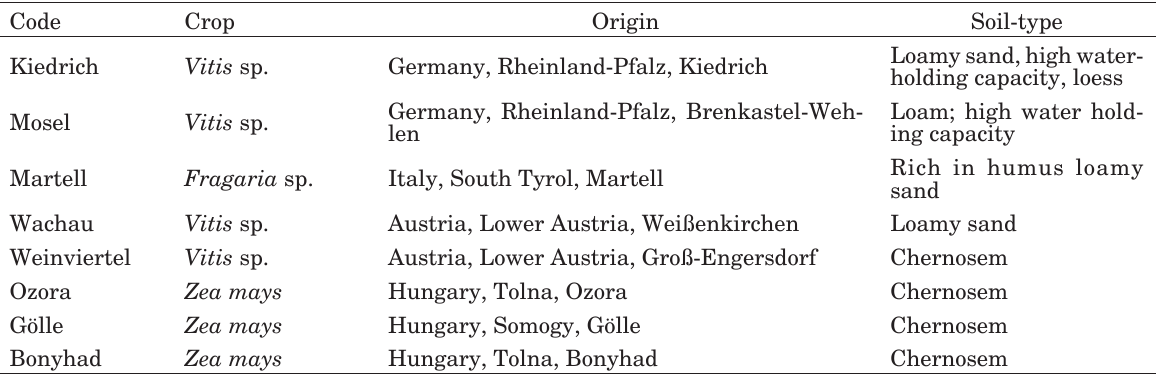
Table 2. Soil samples used for the development of the DNA extraction protocol. Code